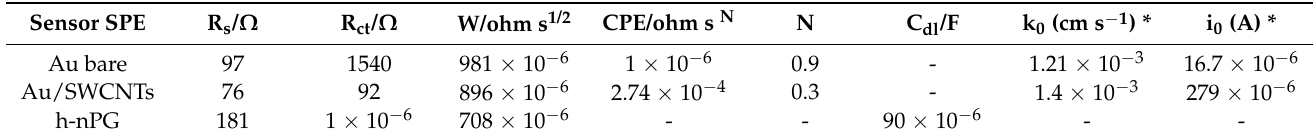
Table 2. EIS results from the electrochemical Nyquist plots fitting.